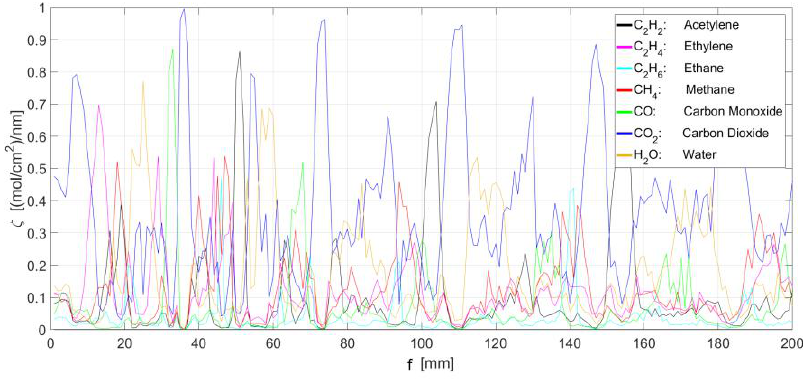
Figure 5. Relative absorption, ζ, of each key gas as function of focal